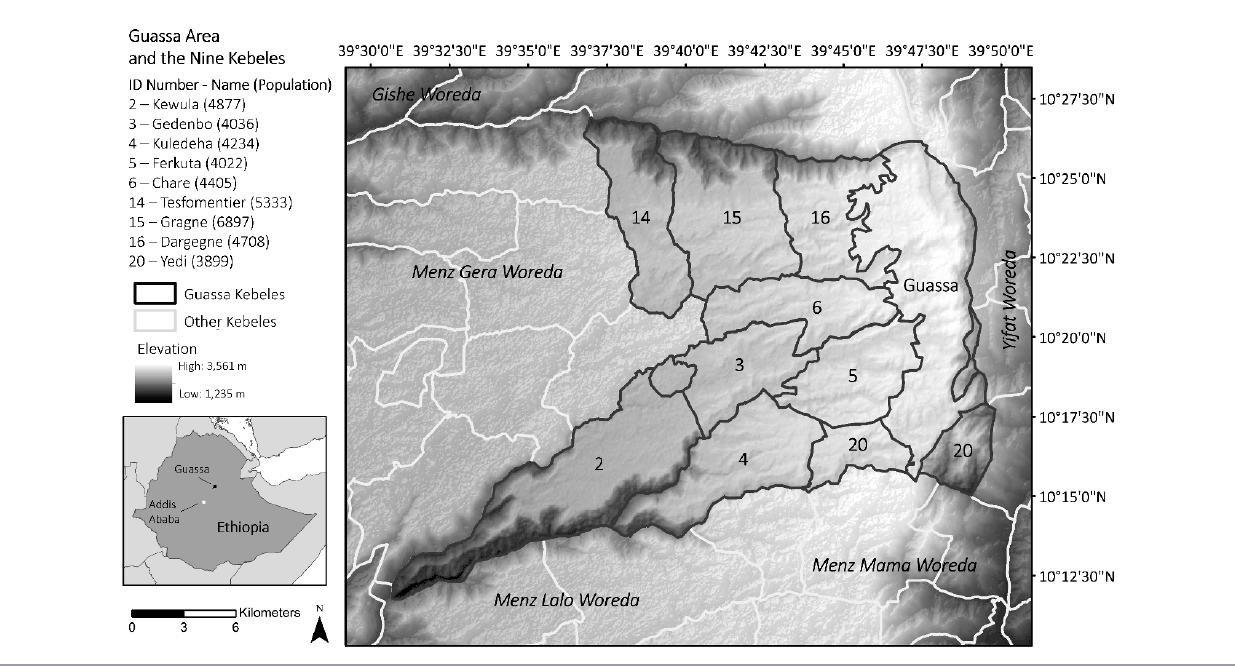
Fig. 1 . The identifying numbers, names, population, and administrative boundaries of the nine kebeles (communities; in black) with ancestral rights to Guassa. These kebeles are all part of the Menz Gera woreda (county or district), and their numbered identifiers are used interchangeably with their local names (note: kebele 20, “Yedi”, is located in two separate areas). Guassa has no human population and is administered separately as a community conservation